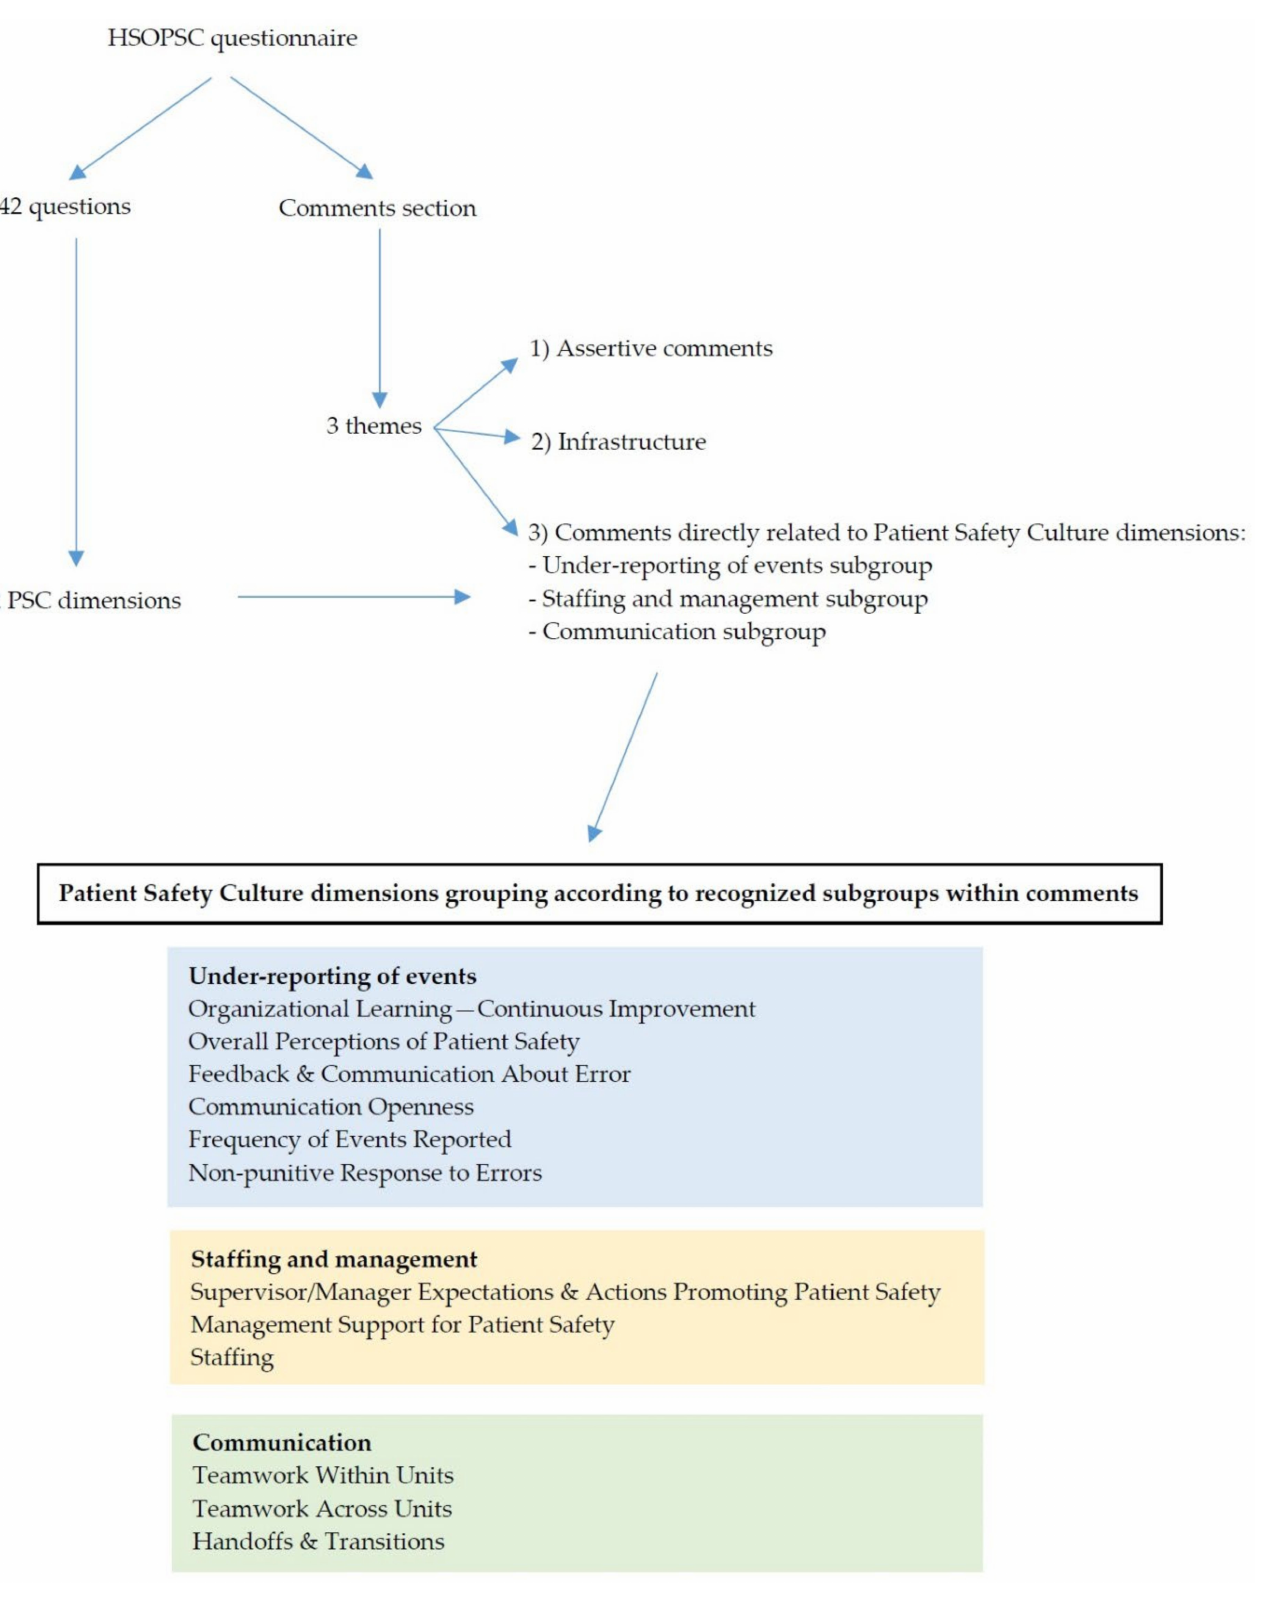
Scheme 1. Model of this mixed-method